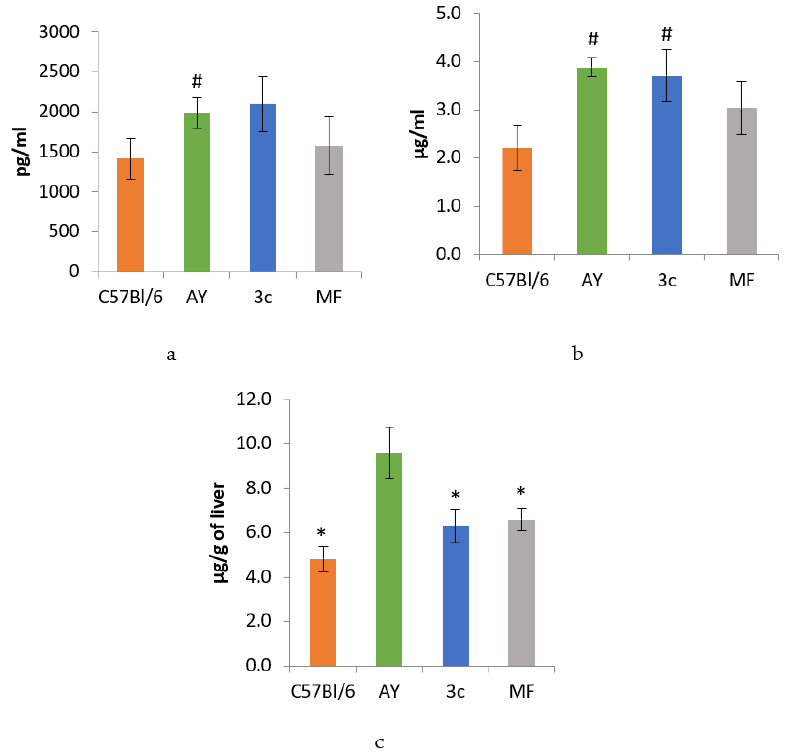
Figure 7. ELISA results. ( a ) Insulin levels in plasma of mice at the end of the experiment. ( b ) Level of adiponectin in plasma of mice at the end of the experiment. ( c ) The amount of glucokinase in the liver of mice at the end of the experiment. * p < 0.05 as compared to AY mice; # p < 0.05 as compared to C57Bl/6 mice.